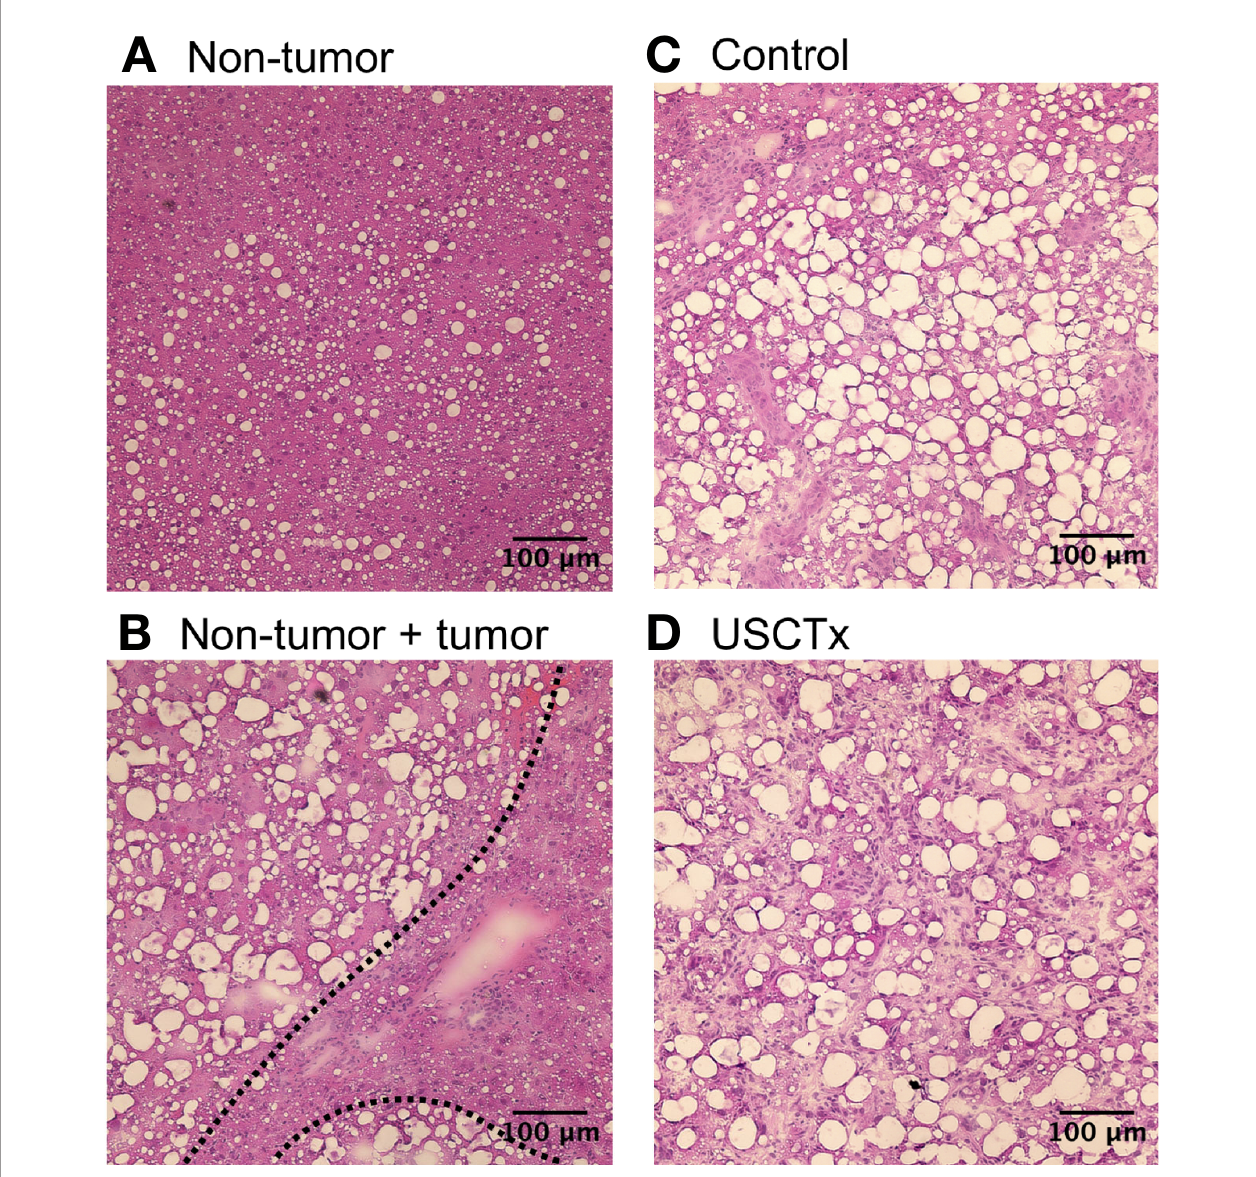
FIGURE 10 | Examples of H&E stained images from non-tumor tissue (A) , the boundary between non-tumor and tumor tissue (B) , control tumorous tissue (C) and USCTx tumorous tissue (D) . No tissue damage was observed in any